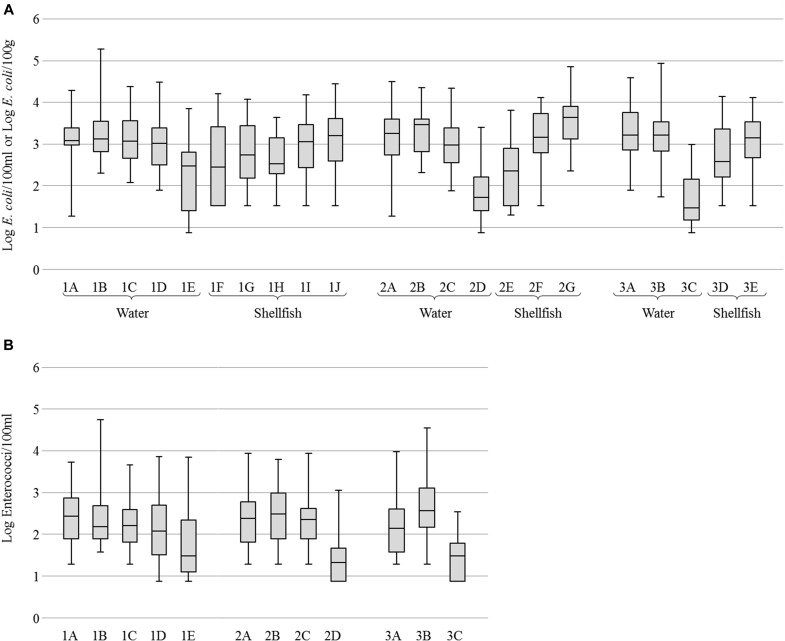
Enumeration of fecal indicator bacteria. (A) Boxplots of Escherichia coli concentration in water and shellfish. (B) Boxplots of Enterococci concentration in water. Boxplots show the minimum, the 25th percentile, the median, the 75th percentile and the maximum concentration. For water samples, 1E, 2D, and 3C correspond to seawater and others to river or brackish water. For shellfish samples, 1F, 1H, 2E, and 3D correspond to oysters, 1G, 1I, 2F, and 3E to mussels, and 1J and 2G to cockles.